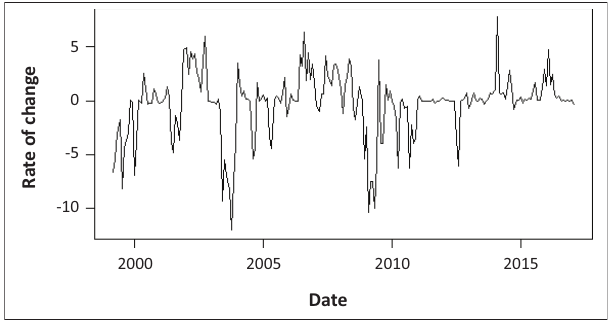
FIGURE 2: South Africa – Movement of the rate of change of monthly interest rates.